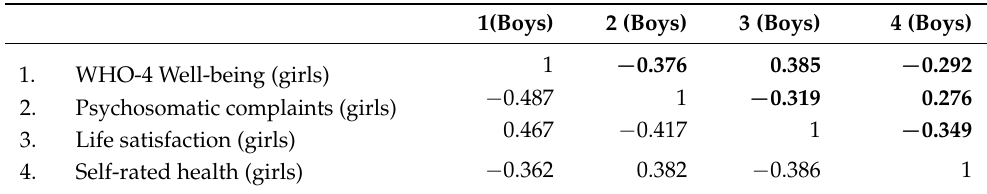
Table 7. Convergent validity by gender: correlation coefficients using aggregated data ( N =